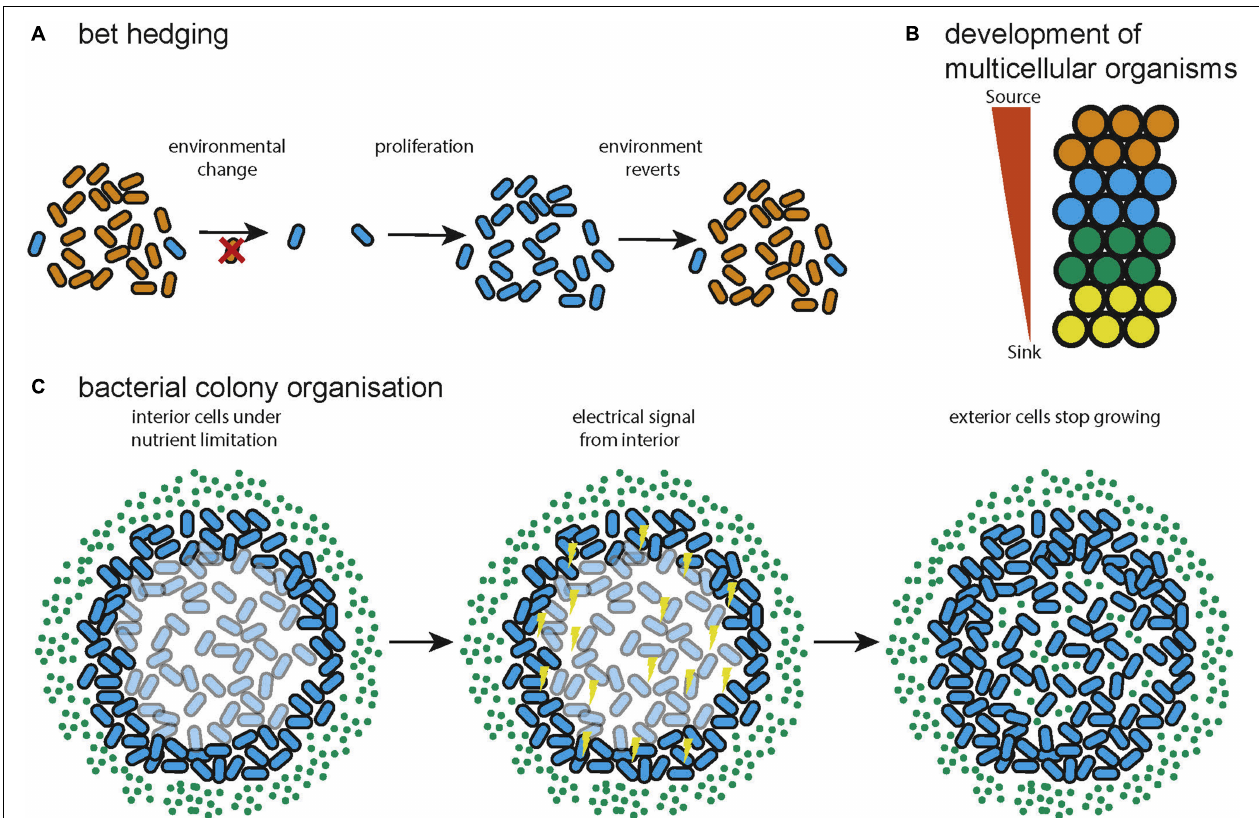
FIGURE 3 | Examples of distributed systems in nature. (A) Bet hedging in natural bacterial communities, variation in the phenotype of the cells confers resistance to environmental change to the community (adapted from Wolf et al., 2005). (B) During multicellular development spatial information can be specified by gradients of diffusible molecules (adapted from Yu et al., 2009). (C) Bacteria can use electrical signaling to organize metabolism so that both interior and exterior cells can grow (adapted from Martinez-Corral et al.,